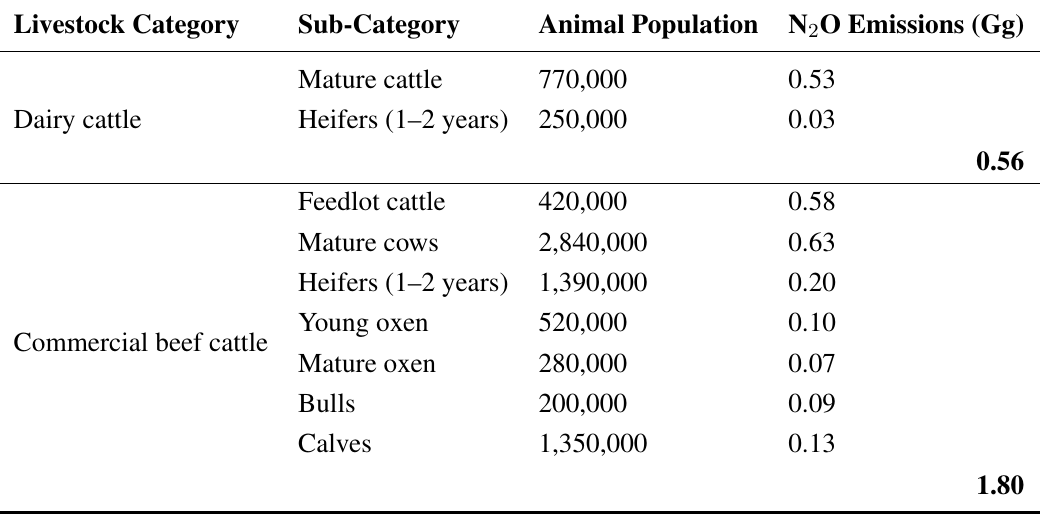
Figure 2. N O emissions from manure management per livestock category for 2004. 2 Table 8. N O emissions from manure management per livestock sub-category for 2004. 2 Livestock Category